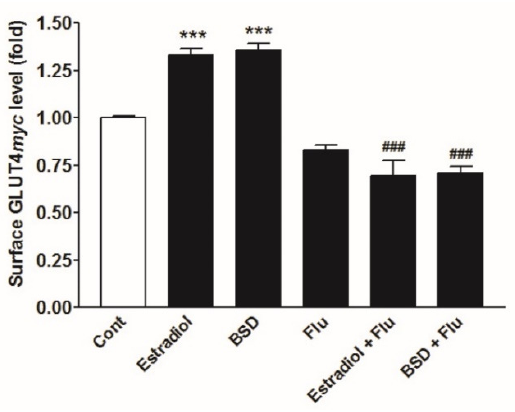
Figure 6. Effect of fulvestrant on BSD-induced GLUT4 translocation in GLUT4 myc myotubes. Cells were incubated with Estradiol (10 nM) or BSD (10 µ M) in the presence or absence of fulvestrant (Flu) for 16h, followed by the determination of the proportion of GLUT4 myc at the cell surface. Results are expressed as fold stimulation over control. Results shown are mean ± SE of three independent experiments. *** p < 0.001 relative to control and ### p < 0.01 relative to respective fulvestrant negative condition.